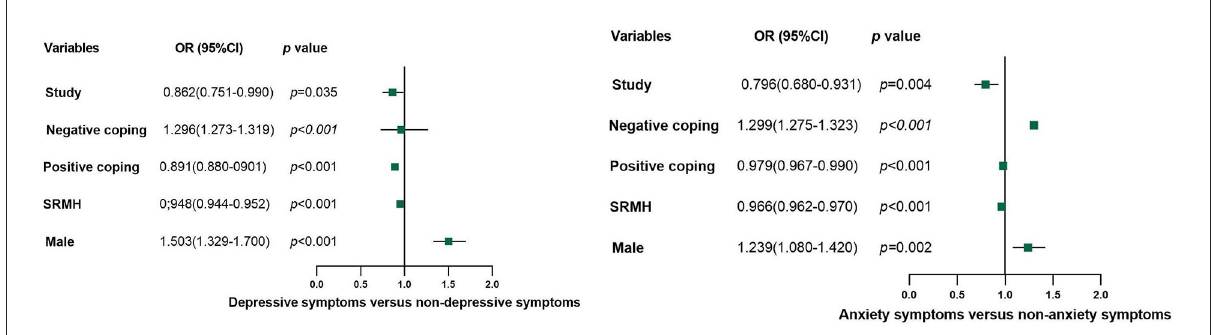
FIGURE2 Influencing factors that may be associated with depressive symptoms and anxiety symptoms.